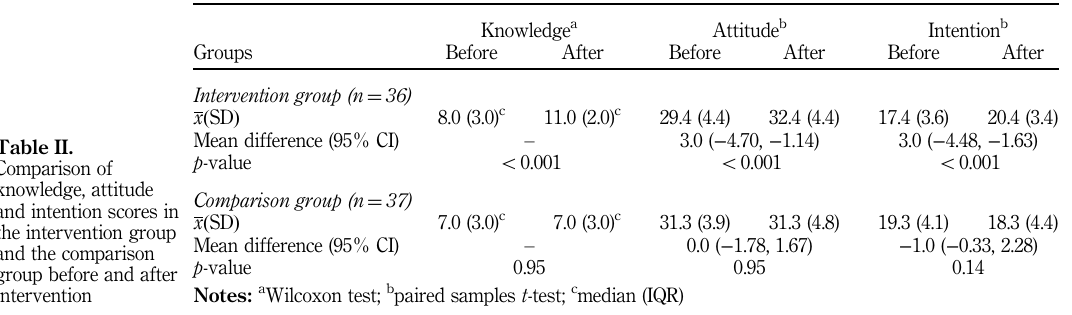
Knowledge a Attitude b